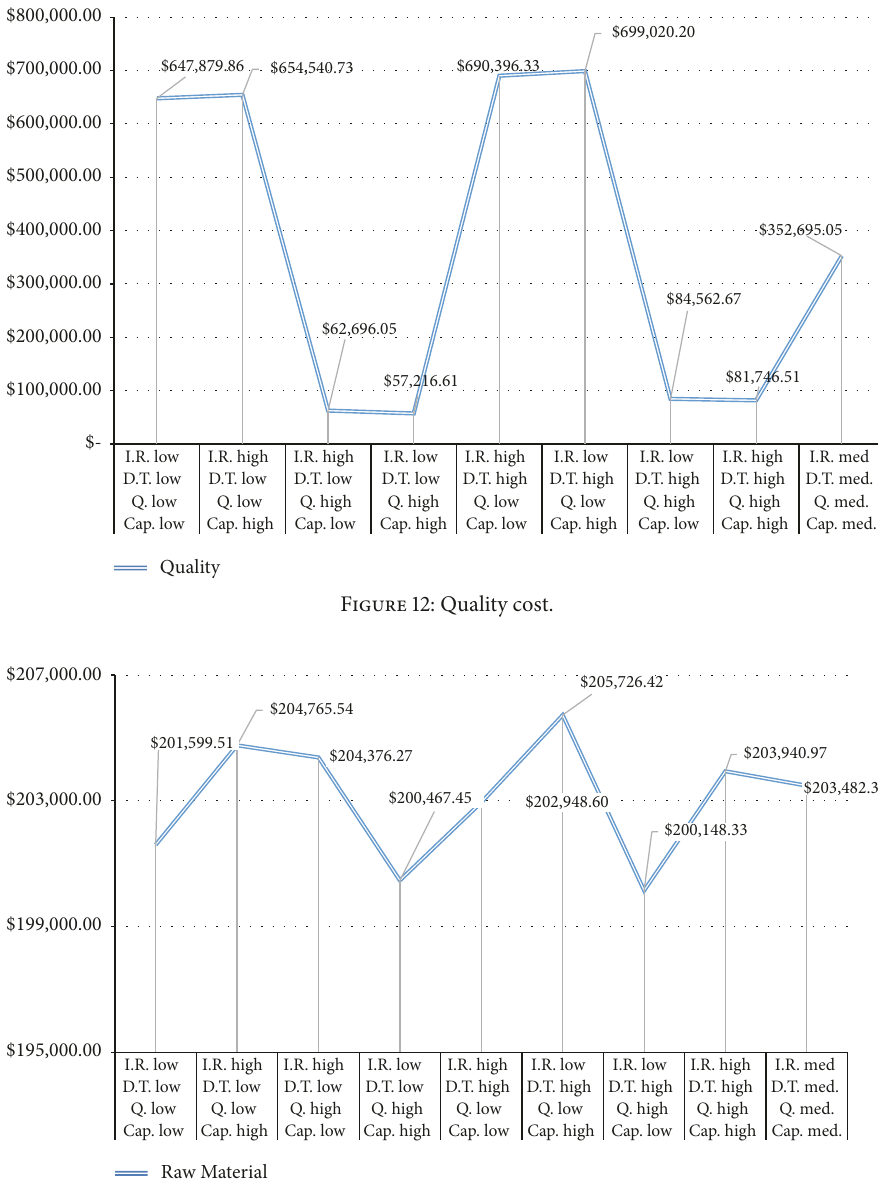
Figure 13: Raw material